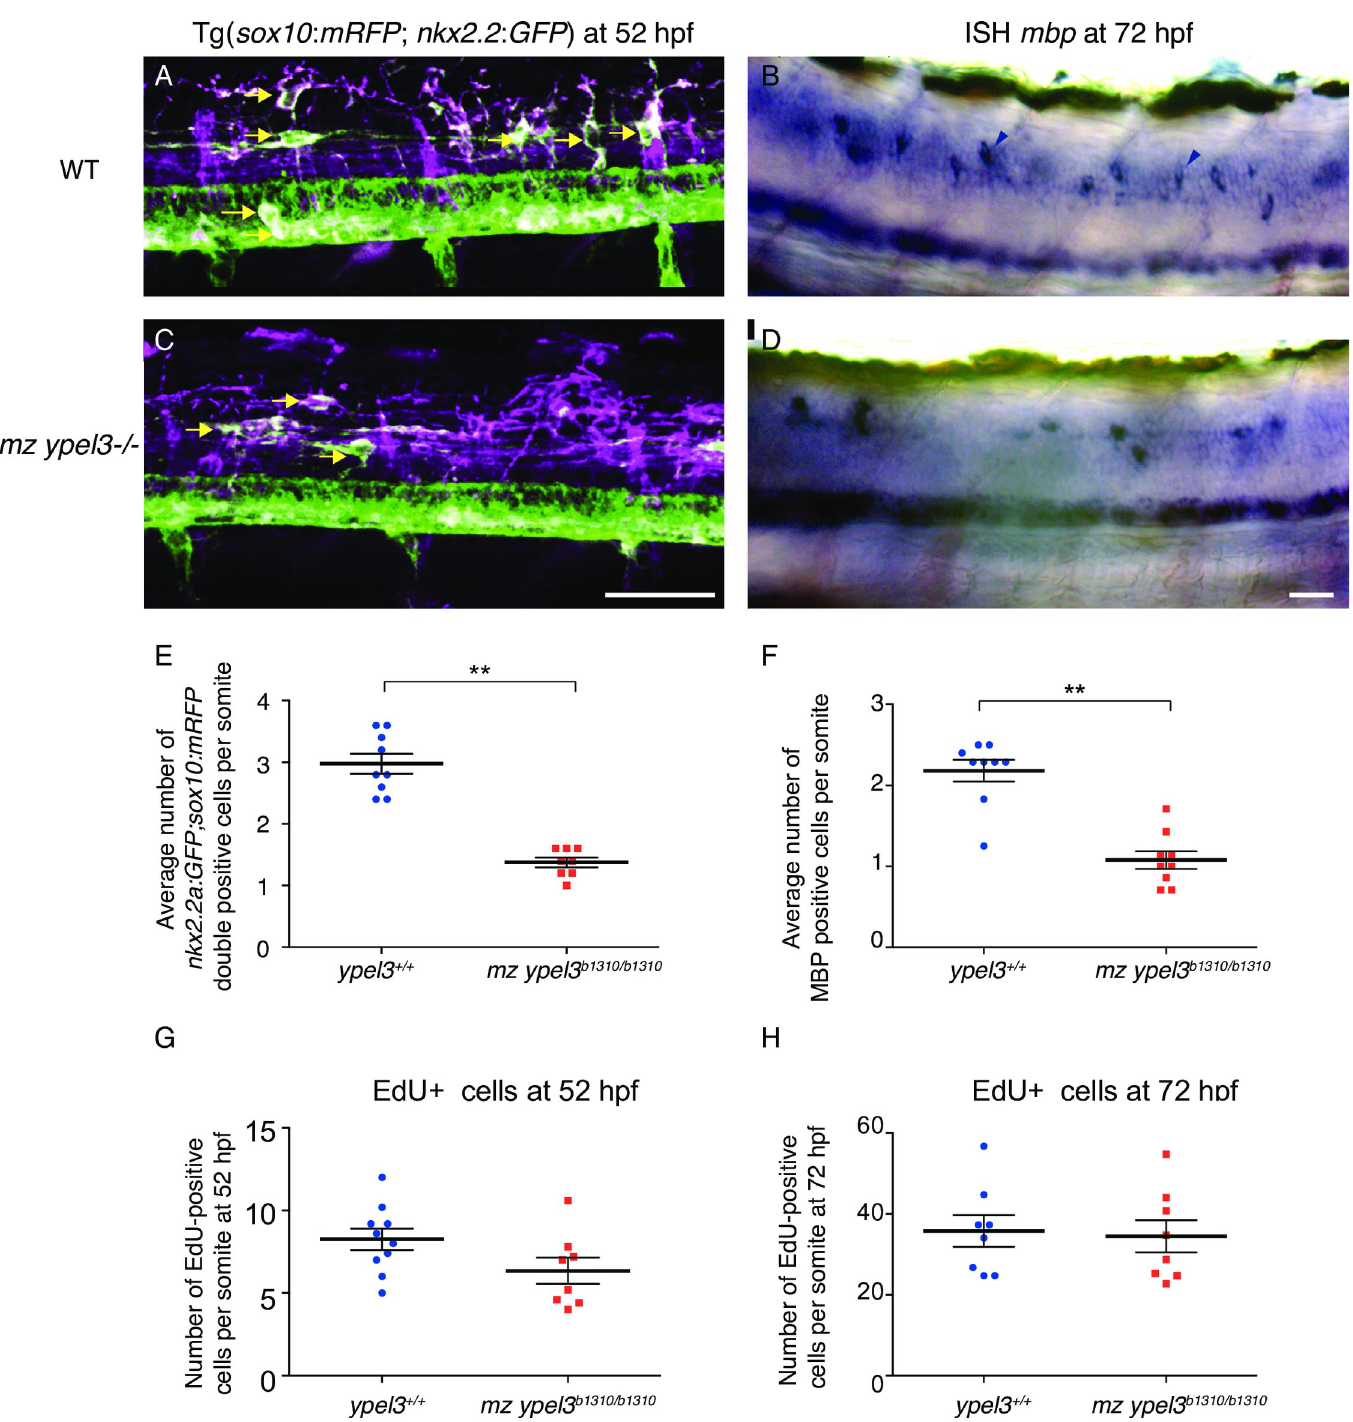
Fig 4. ypel3 is required for myelinating oligodendrocyte development. ( A-B ) WT larvae at 52 hpf ( A ) and at 72 hpf ( B ). ( C-D ) mz ypel3 mutants at 52 hpf ( C ) and at 72 hpf ( D ). Arrows indicate myelinating oligodendrocytes (double mRFP, mGFP positive cells) in ( A ) and ( C ). Black arrowheads show myelinating oligodendrocytes expressing mbpb in ( B and D ). Scale bars: 25 μ m. Images are lateral views. ( E-H ) Quantification of the number of myelinating oligodendrocytes at 52 hpf ( E ), mbpb expressing cells at 72 hpf ( F ), EdU positive cells at 52 hpf ( G ) and 72 hpf ( H ). Bars represent +/- SEM.